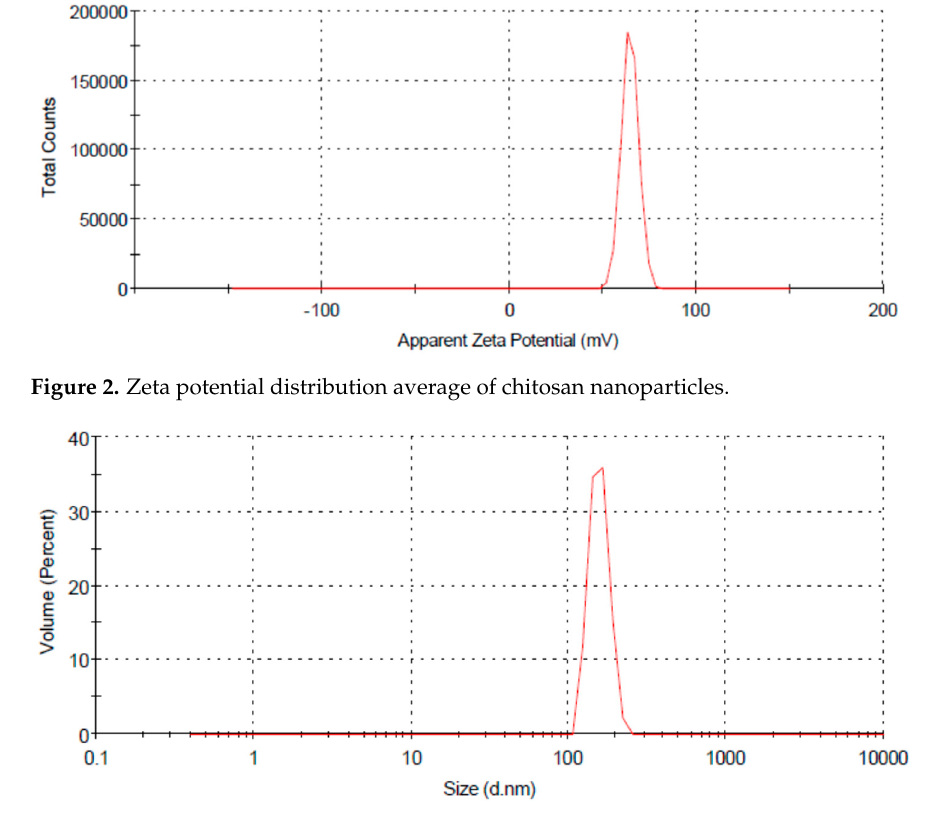
Figure 3. Z average size of chitosan nanoparticles, 100–156 nm.